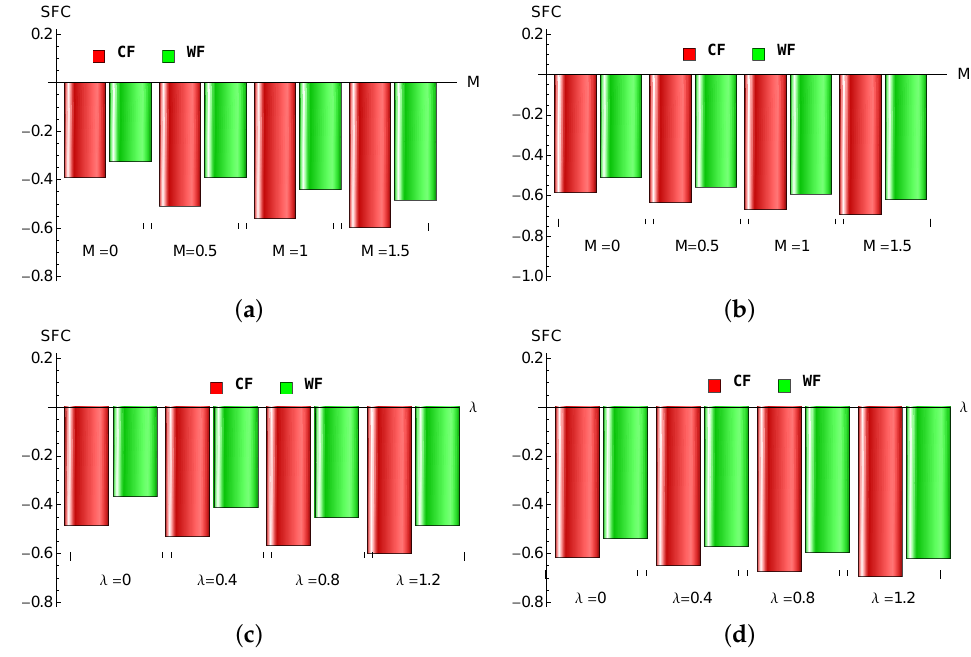
Figure 5. The skin friction coefficient (SFC) for different values of M with fw = − 0.6 ( a ), M with fw = 0.6 ( b ), λ with fw = − 0.6 ( c ) and λ with fw = 0.6 ( d ) for Casson nanofluid (CF) and Williamson nanofluid